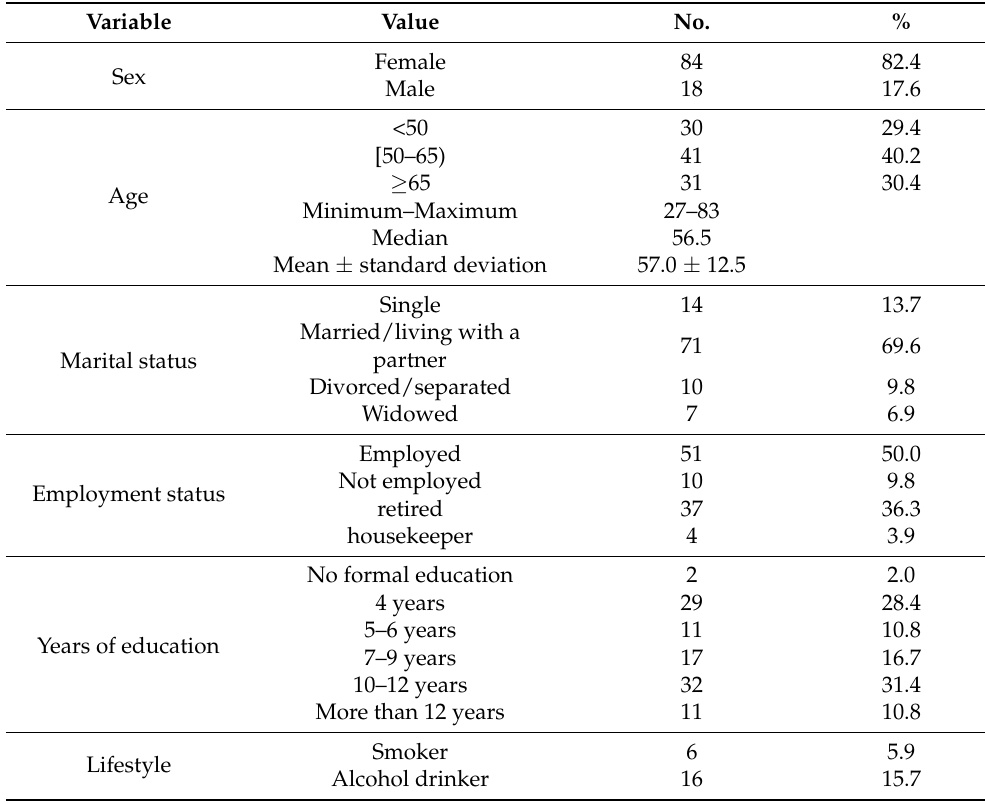
Table 1. Sociodemographic characteristics of patients ( n =